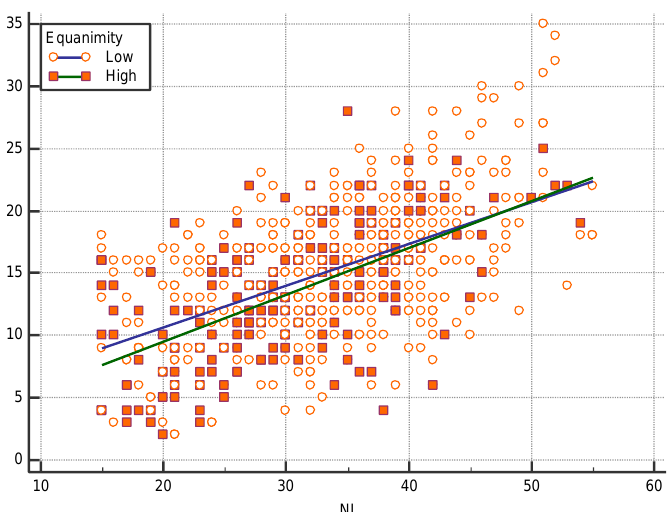
Figure A1. Possible moderated mediation models.